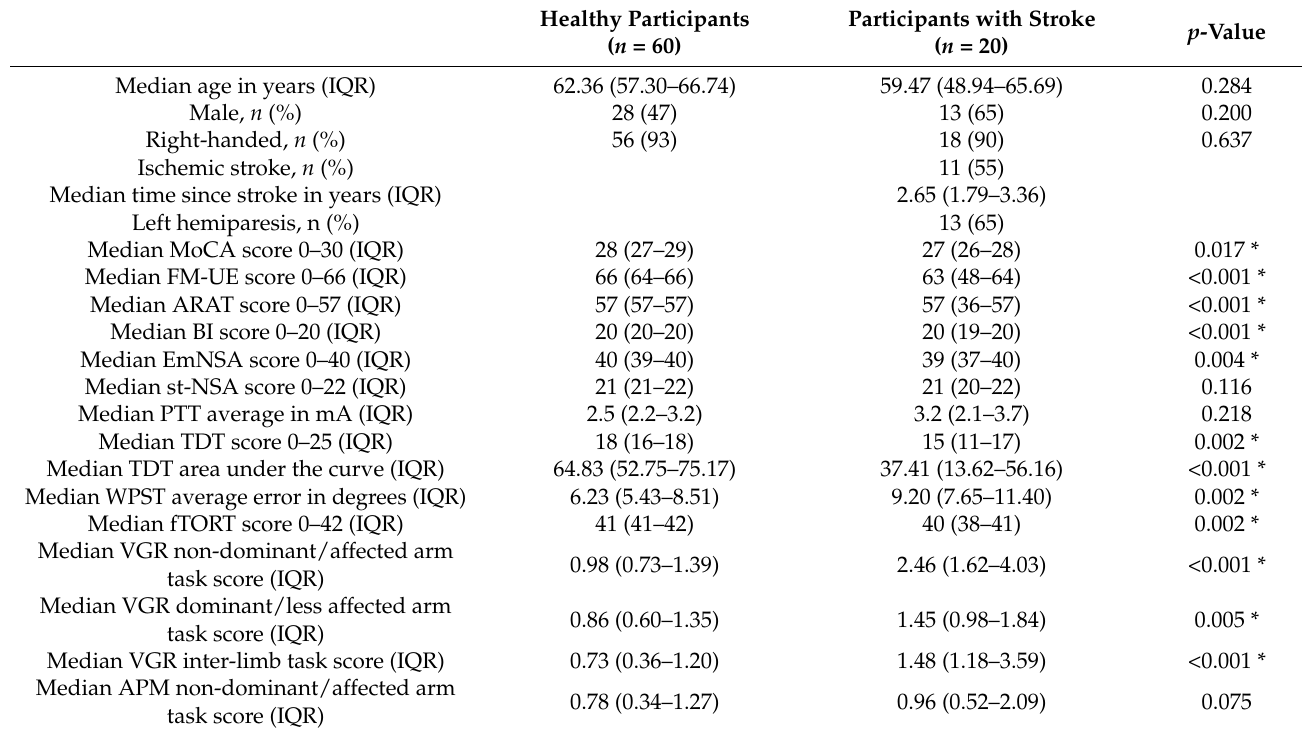
Table 1. Participant